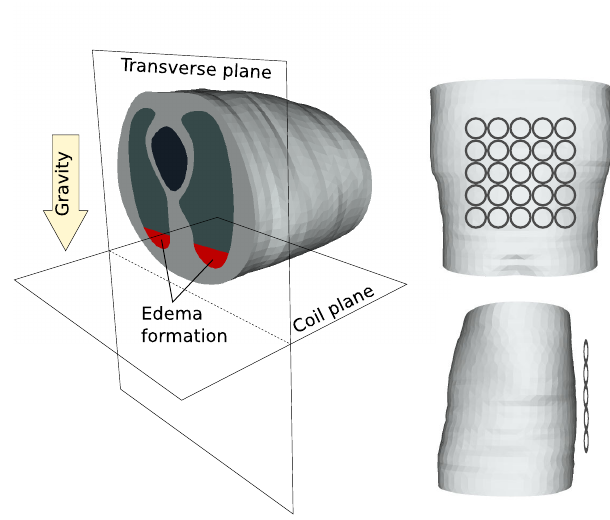
in simulations. Red regions within the lungs represent the fluid accumulation, i.e., edema formation regions, due to